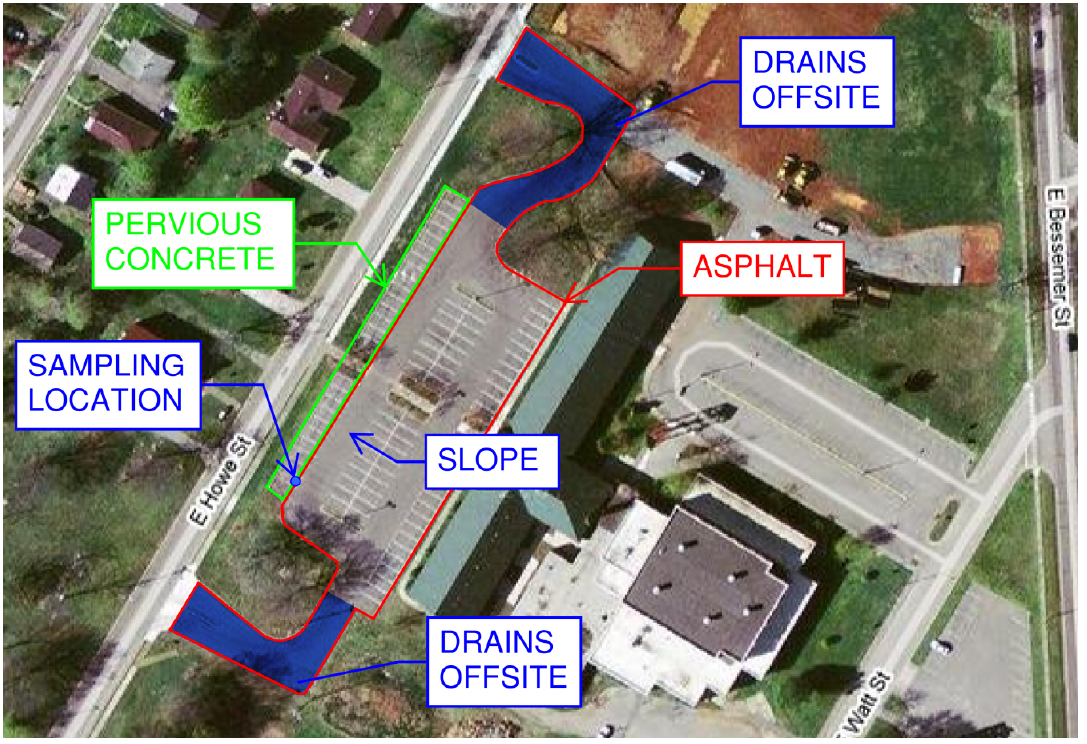
Figure 1. The Alcoa City Center site.